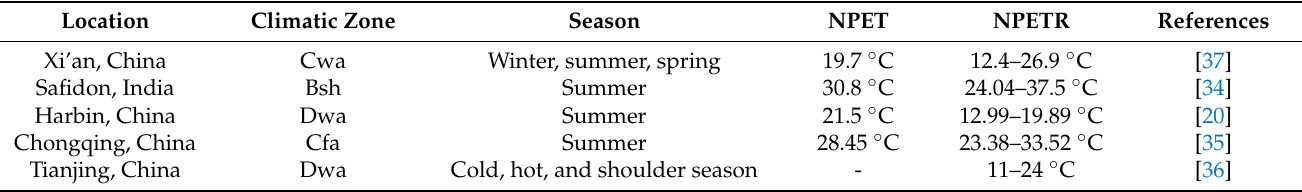
Table 5. NPET and NPETR in other outdoor thermal comfort studies.